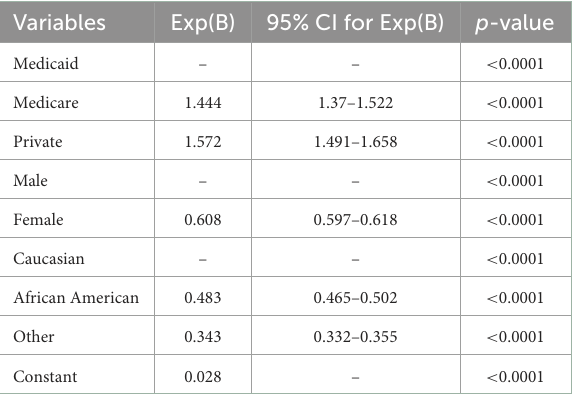
TABLE 3 Logistic regression evaluating the effects of the different demographic variables on likelihood of undergoing catheter ablation.